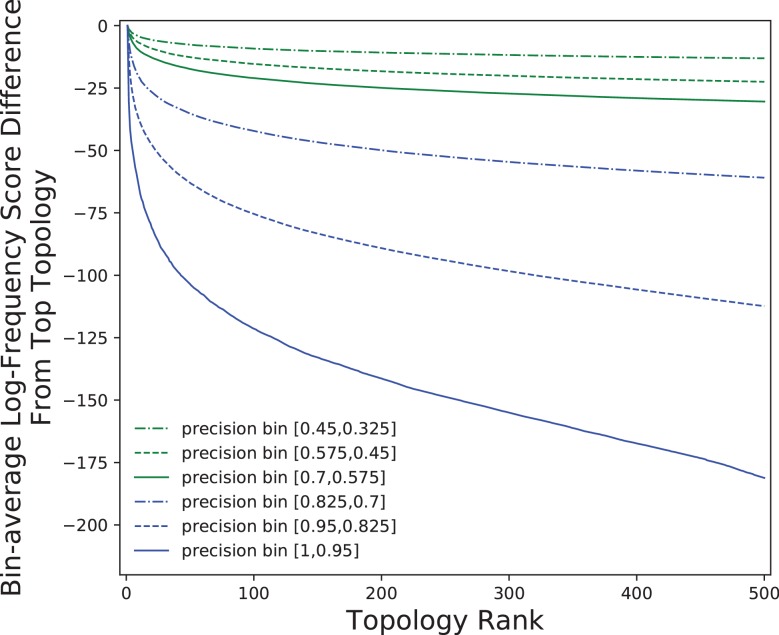
Dropoff in ASPEN log-frequency scores across precision bins.Comparison of log-frequency scores of the top 500 ASPEN topologies for simulated families across six precision bins. The difference between a topology’s score and the score of the best ASPEN topology, averaged over all families in the bin, is plotted as a function of topology rank.